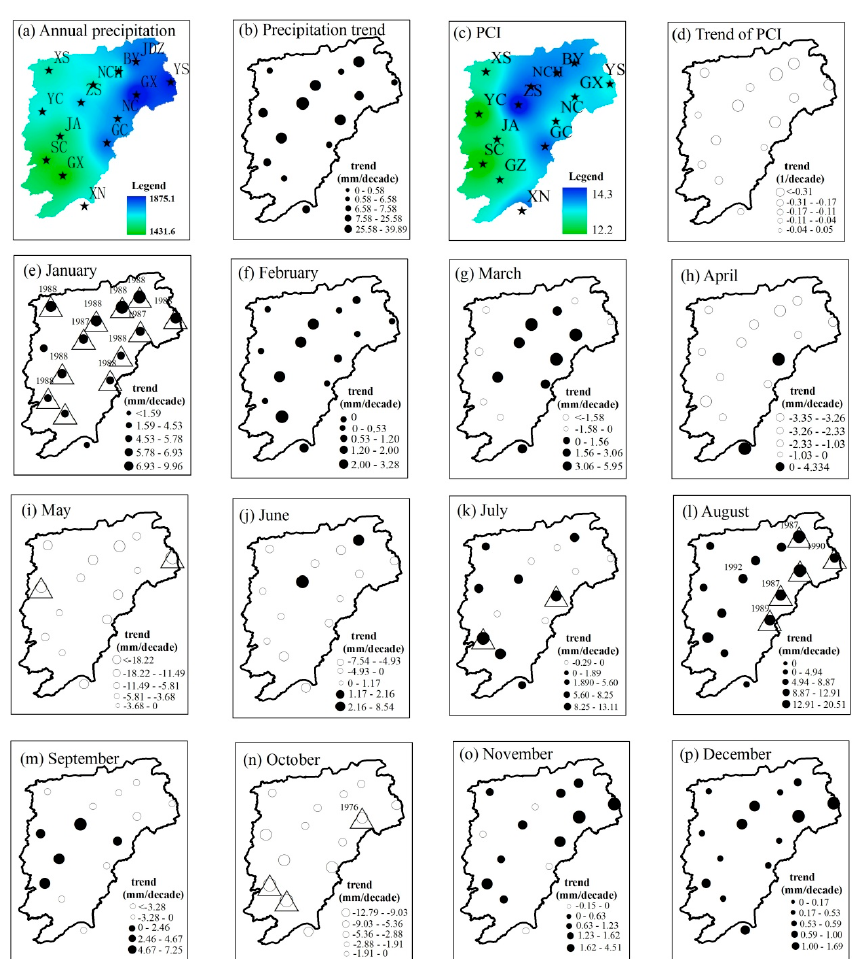
Figure 6. Distribution of annual precipitation ( a ); the trend of annual precipitation ( b ); distribution of PCI ( c ); trend of PCI ( d ); and trend of monthly precipitation ( e – p ) (filled circle denotes increasing trend, un ‐ filled circle denotes decreasing trend, circle with triangle denotes the trend was significant at P ≤ 0.1).